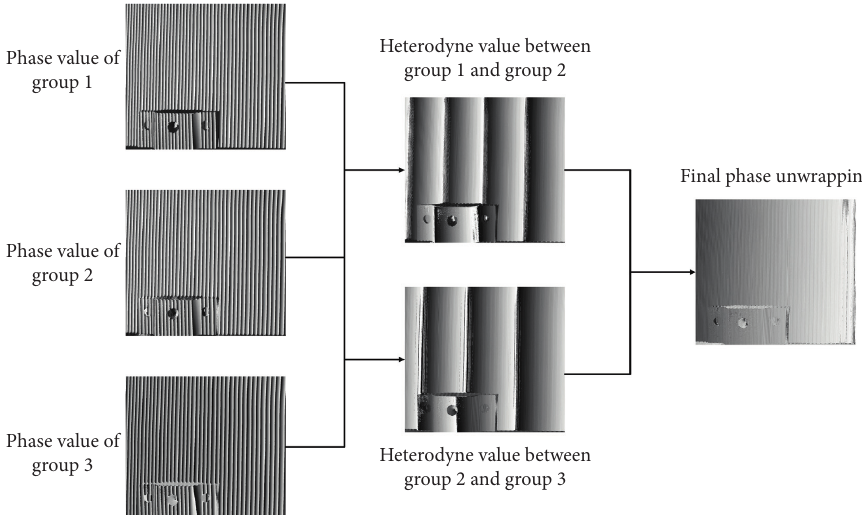
Figure 10: Flowchart of the heterodyne multifrequency phase-shifted